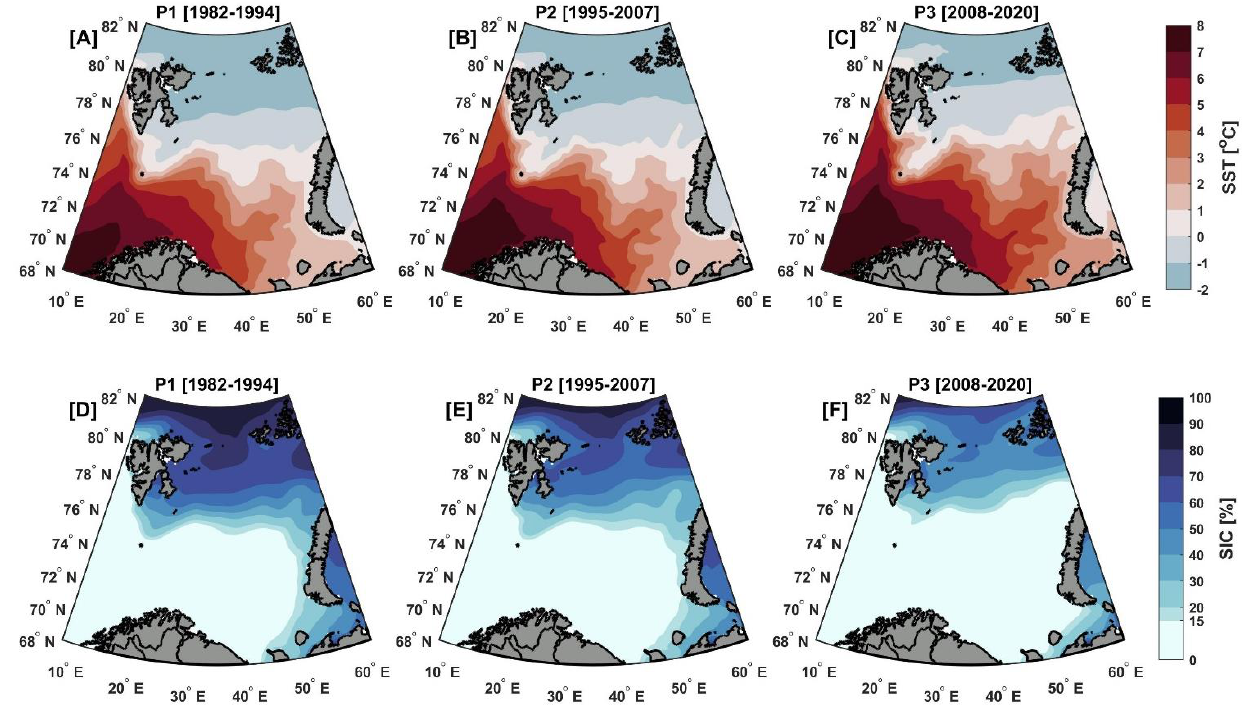
Figure 2. The climatological mean of SST (upper panels) and SIC (lower panels) for the periods; ( A , D ) P1 (1982 – 1994), ( B , E ) P2 (1995 – 2007), and ( C , F ) P3 (2008 – 2020). The contour lines are indicated ( A , D ) P1 (1982–1994), ( B , E ) P2 (1995–2007), and ( C , F ) P3 (2008–2020). The contour lines are indicated by the respective labels to the right. by the respective labels to the